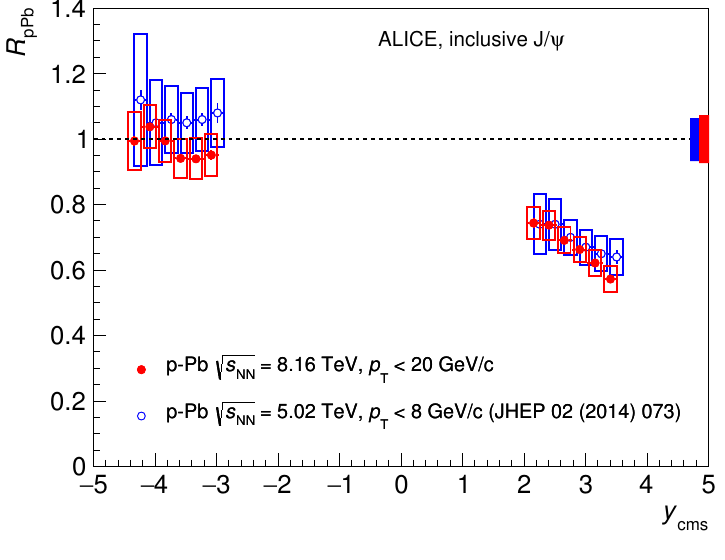
p s NN = p s NN = 5 : 02 TeV [28]. The latter